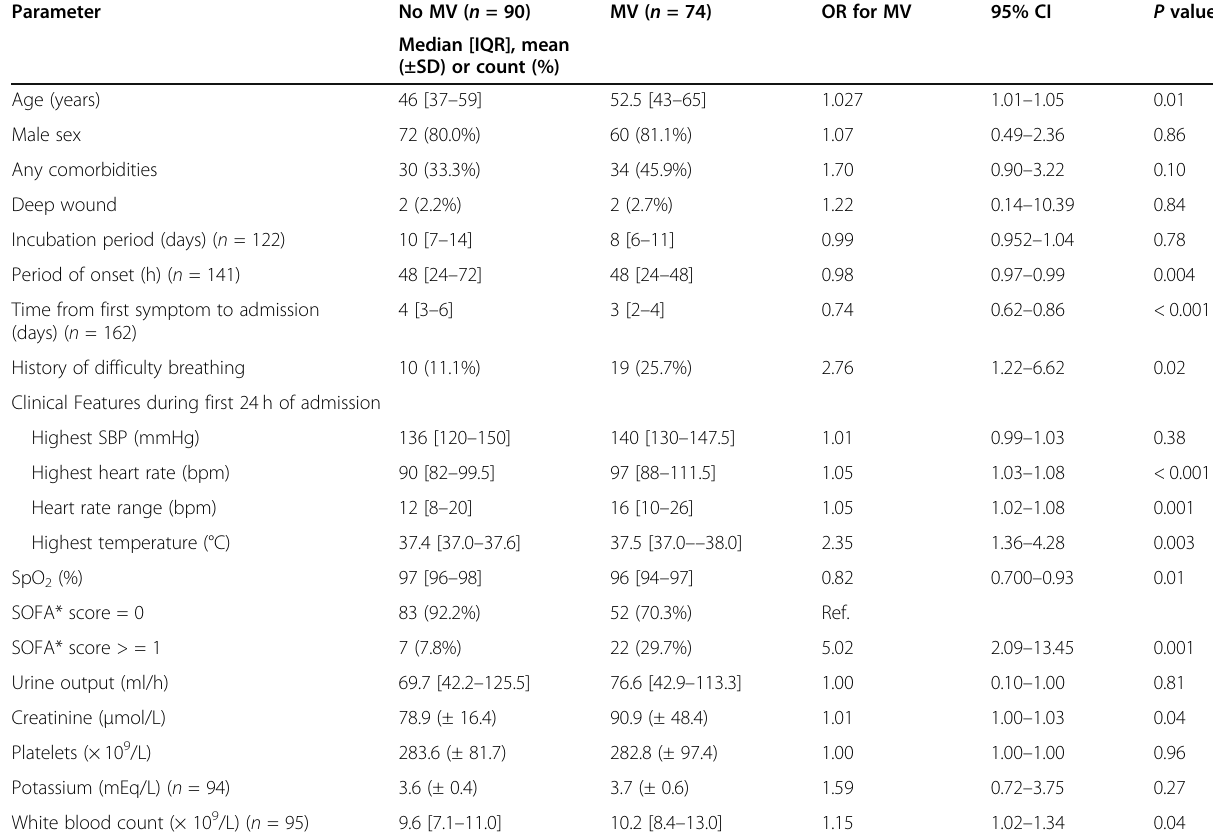
Table 2 Tetanus risk factors for mechanical ventilation ( n = 164)